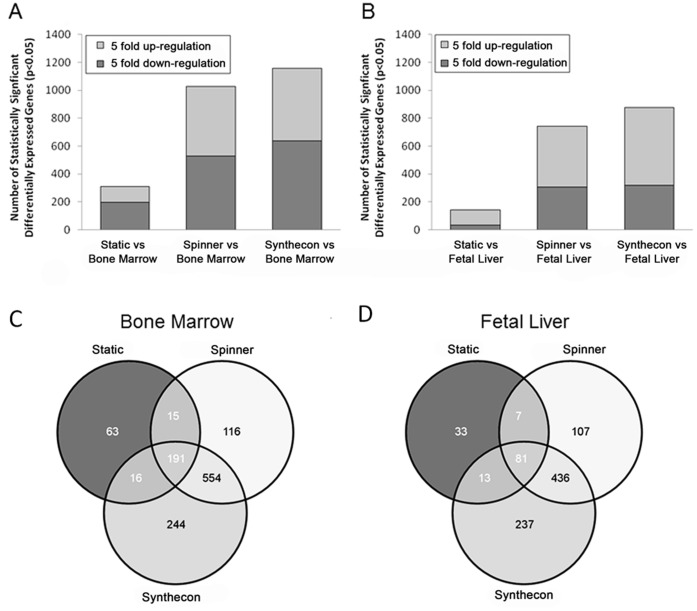
Differentially expressed genes in various LKS cell populations.Numbers of differentially expressed genes in Lin-ckit+Sca-1+ progenitor cells generated under Static, Spinner flask, and Synthecon rotary culture conditions with a 5-fold difference compared to LKS cells from bone marrow and fetal liver. ESC-derived Lin-ckit+Sca-1+ cells from all ESC conditions had fewer differentially expressed genes (p<0.05) relative to FL LKS cells (B) than to BM LKS cells (A). Expression profiles derived from Static culture conditions were more similar to BM and FL LKS cells expression patterns than were those generated under dynamic (Spinner flask or Synthecon) conditions. Venn diagram of genes differentially expressed (p<0.05) in Lin-ckit+Sca-1+ progenitor cells generated under Static, Spinner flask, and Synthecon rotary culture conditions with a 5-fold difference compared to LKS cells isolated from bone marrow (C) or fetal liver (D). Many genes were differentially expressed only within a particular culture system, and the dynamic culture systems shared the largest number of differentially expressed genes compared to both BM (C) and FL (D).